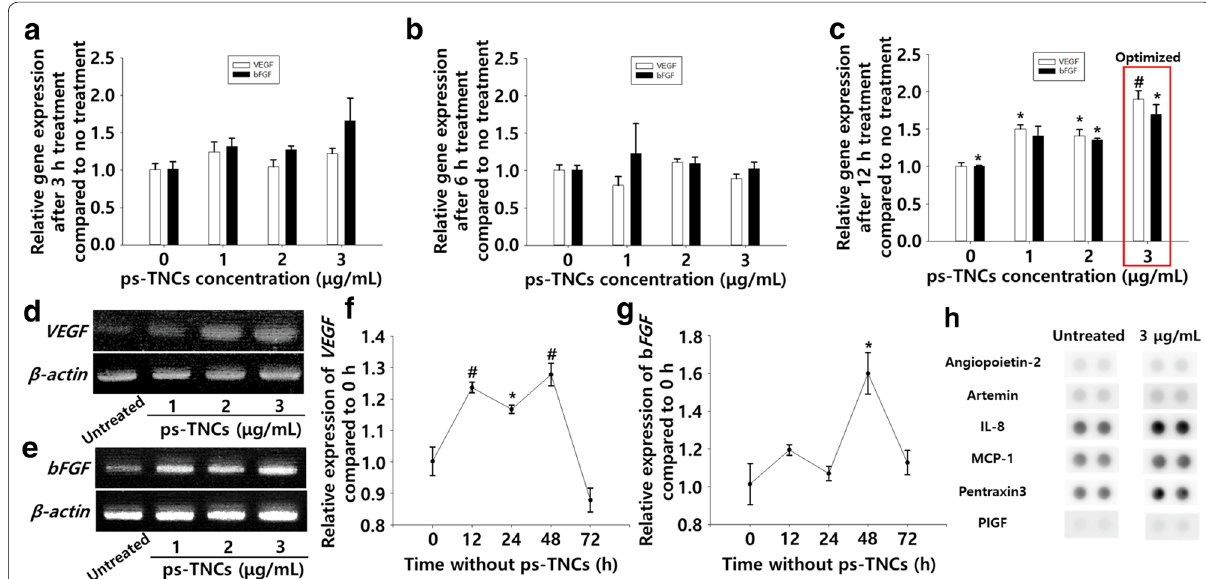
Fig. 5 Enhanced angiogenic potency of hADSCs treated with ps‑TNCs. a – c Concentration‑dependent angiogenic gene expression with different treatment times, quantified by qRT‑PCR. (n 4, * p < 0.05, # p < 0.01 compared to the untreated group). Concentration‑dependent ( d ) VEGF and ( e ) = bFGF gene expression evaluated by RT‑PCR. Duration of ( f ) VEGF and ( g ) bFGF expression in hADSCs after ps‑TNC treatment for 12 h (n and * p < 0.05 compared to the untreated group). h The profile of angiogenesis‑related protein in conditioned medium using human